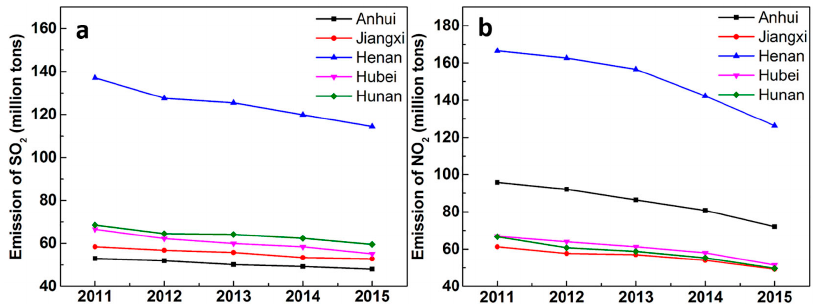
Figure 7. Emissions of ( a ) SO 2 and ( b ) NO 2 over provinces in central China from 2011 to 2015.